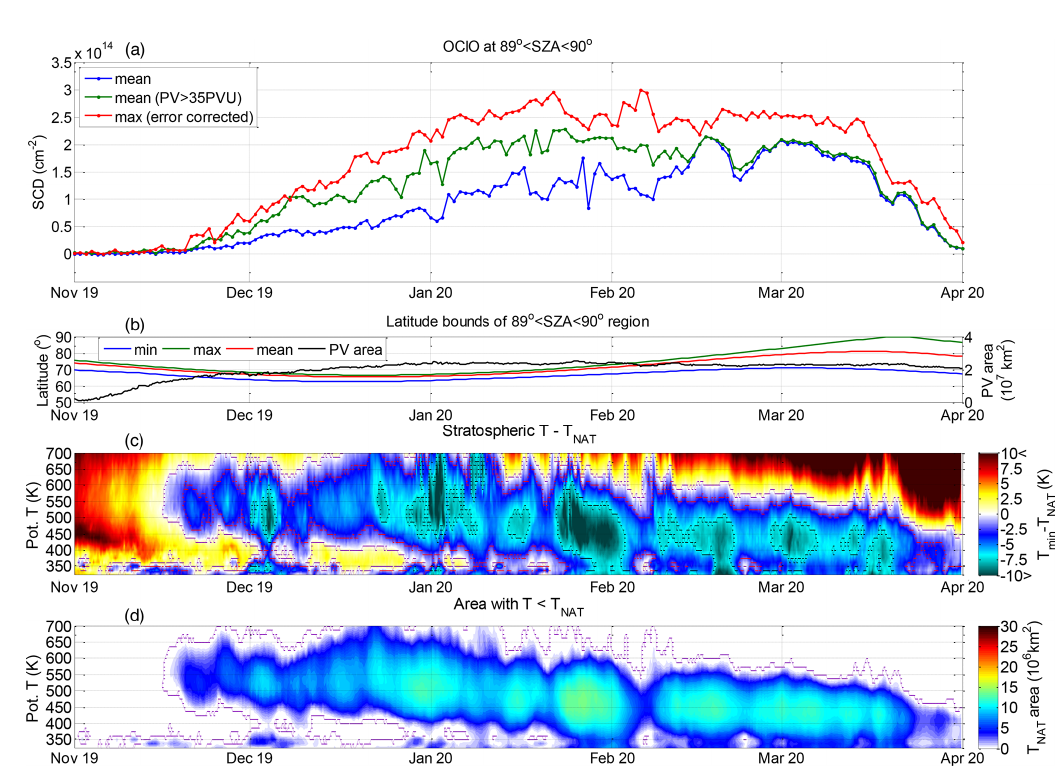
Figure 7. Same as Fig. 1 but for the Arctic winter 2019/20.